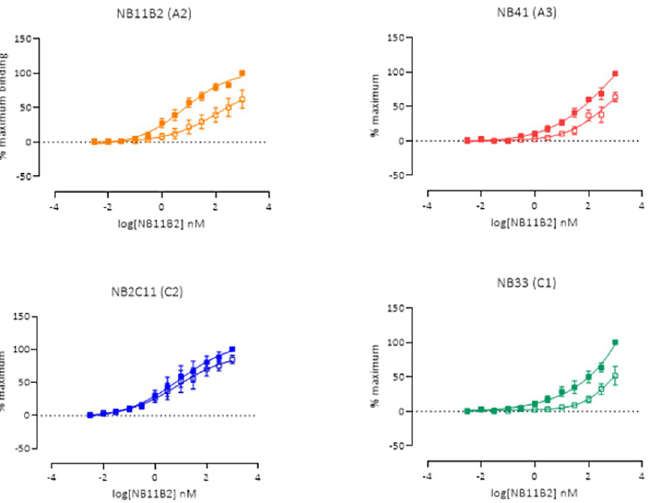
Fig 7. ELISA analysis of FVIII-mAb binding in solid state. Reduction of rFL-FVIII decreases binding of the A2- and A3-specific anti-FVIII antibodies NB11B2 and NB41. The binding of the C1 domain-specific antibody NB33 also decreases, while no change in binding is observed for the C2-specific antibody